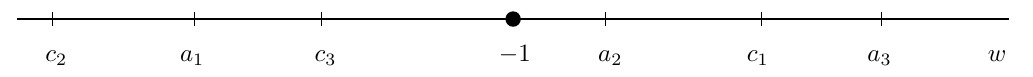
Figure 19. Regions of validity for di(cid:11)erent branches of the potential for various choices of sgn( (cid:22) )sgn( (cid:21) ) and sgn(1 + w ).